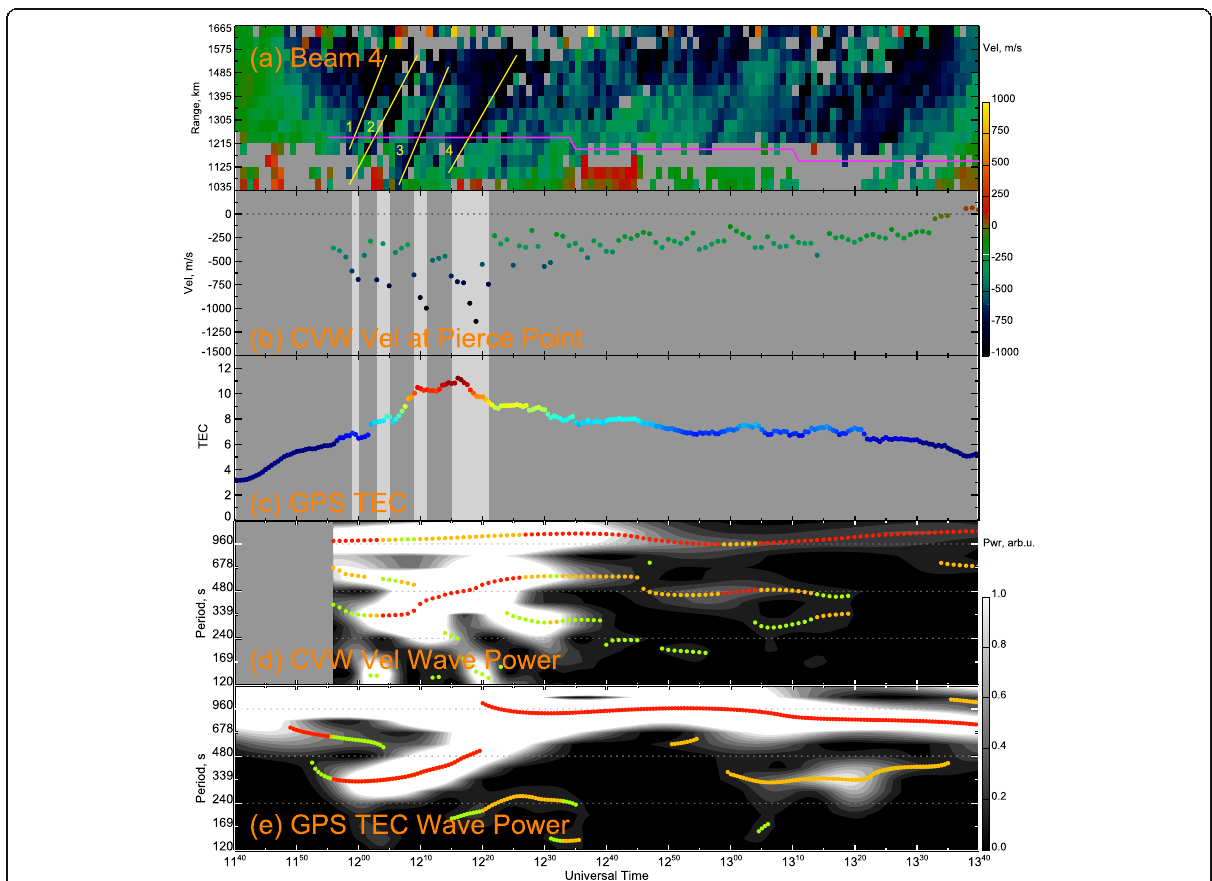
Fig. 15 a CVW velocity versus universal time (UT) and magnetic latitude (MLAT) on 17 March 2013 between 1150 and 1340 UT and slant ranges 1035 – 1665 km. The propagation of SAPS Wavy Structure (SAPSWS) 1 – 4 is shown by yellow lines. The range coincident with Ionospheric Pierce Point (IPP) at 450 km between PRN 21 and Beaver Cove (BCOV) is shown by the pink line. b CVW velocity at IPP. The four periods with velocities < − 500 m s − 1 are highlighted. c GPS TEC measurements at IPP. d Wavelet spectrum of CVW velocity at IPP. e Wavelet spectrum of GPS TEC. The colored dots show the three highest peaks for each spectrum. Reproduced from Fig. 3 of Makarevich and Bristow